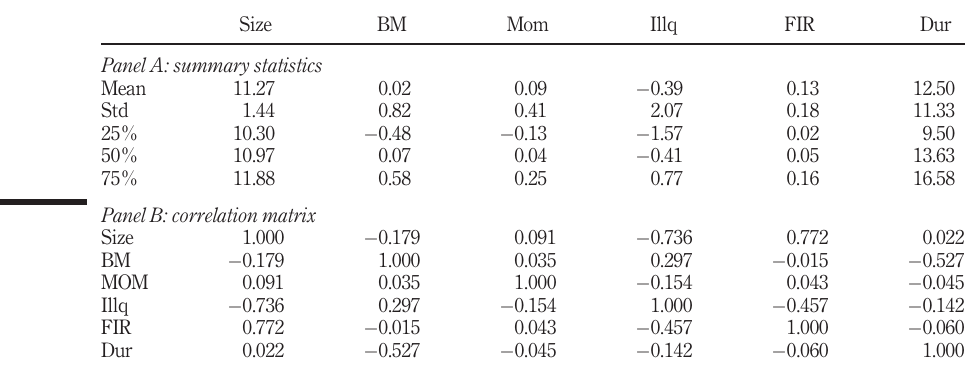
Table 1. Summary